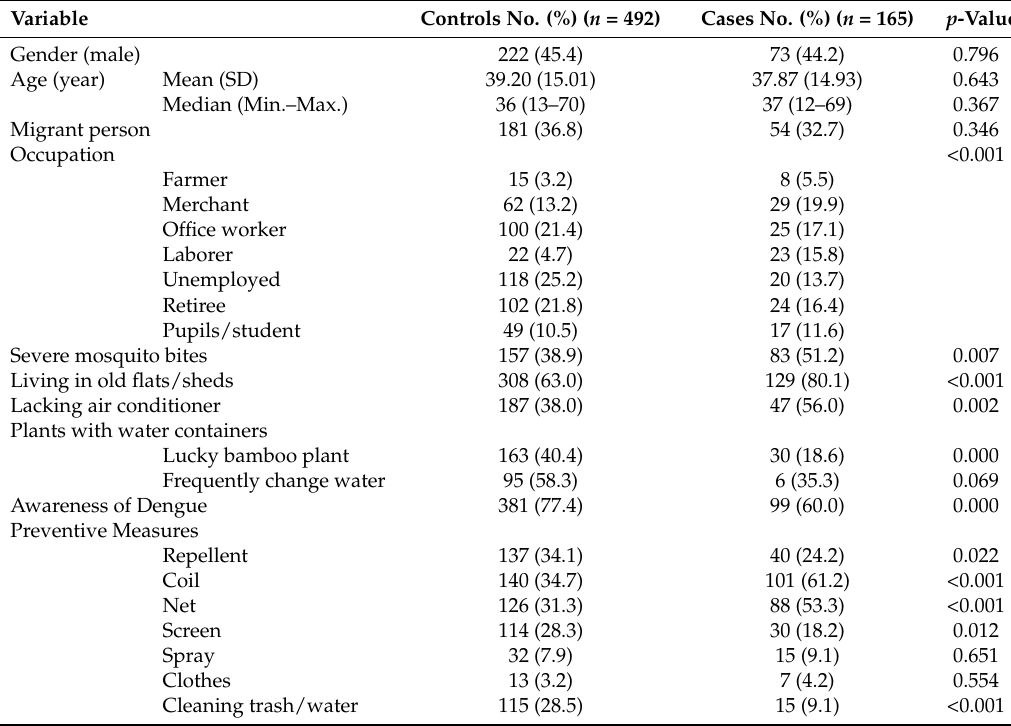
Figure 1. Flow charts for the recruitment of cases and controls to determine populations vulnerable to Dengue Fever infection in the 2014 Guangzhou outbreak. ( A ) Flowchart for telephone surveys conducted with dengue fever (DF) cases; ( B ) Flowchart for face-to-face interviews of controls conducted at 17 local communities. Table 1. Univariate analysis of selected variables for Dengue in Guangzhou outbreak 2014, China.